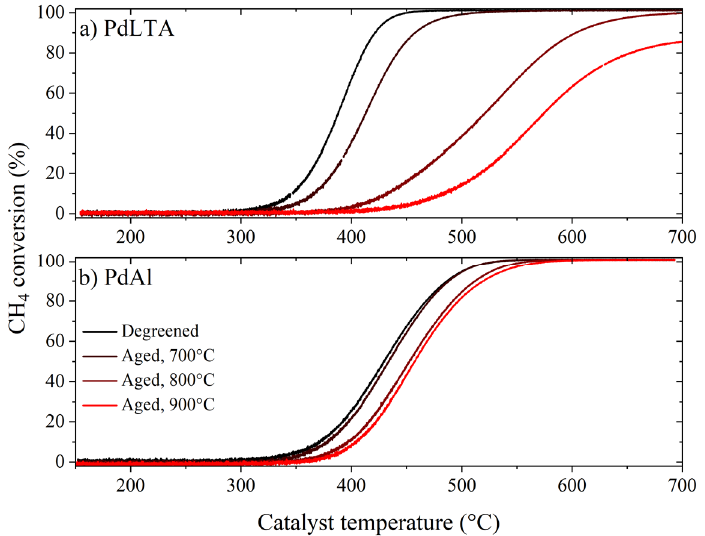
Figure 5. Temperature programmed CH 4 oxidation activity test during heating 5 °C/min for ( a ) PdLTA and ( b ) PdAl, which had been degreened or aged at 700, 800, or 900 °C. Note that this activity test followed directly after the isothermal activity in Figure 4 (without pre-treatment in between). The entire test was performed in wet reaction mixture (500 ppm CH 4 , 8% O 2 , and 5% H 2 O).